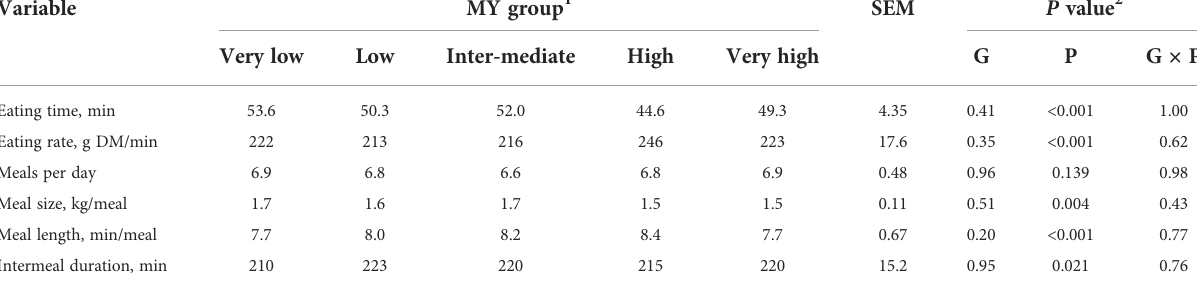
TABLE 4 Feeding behavior of heifers by methane yield (MY) group.